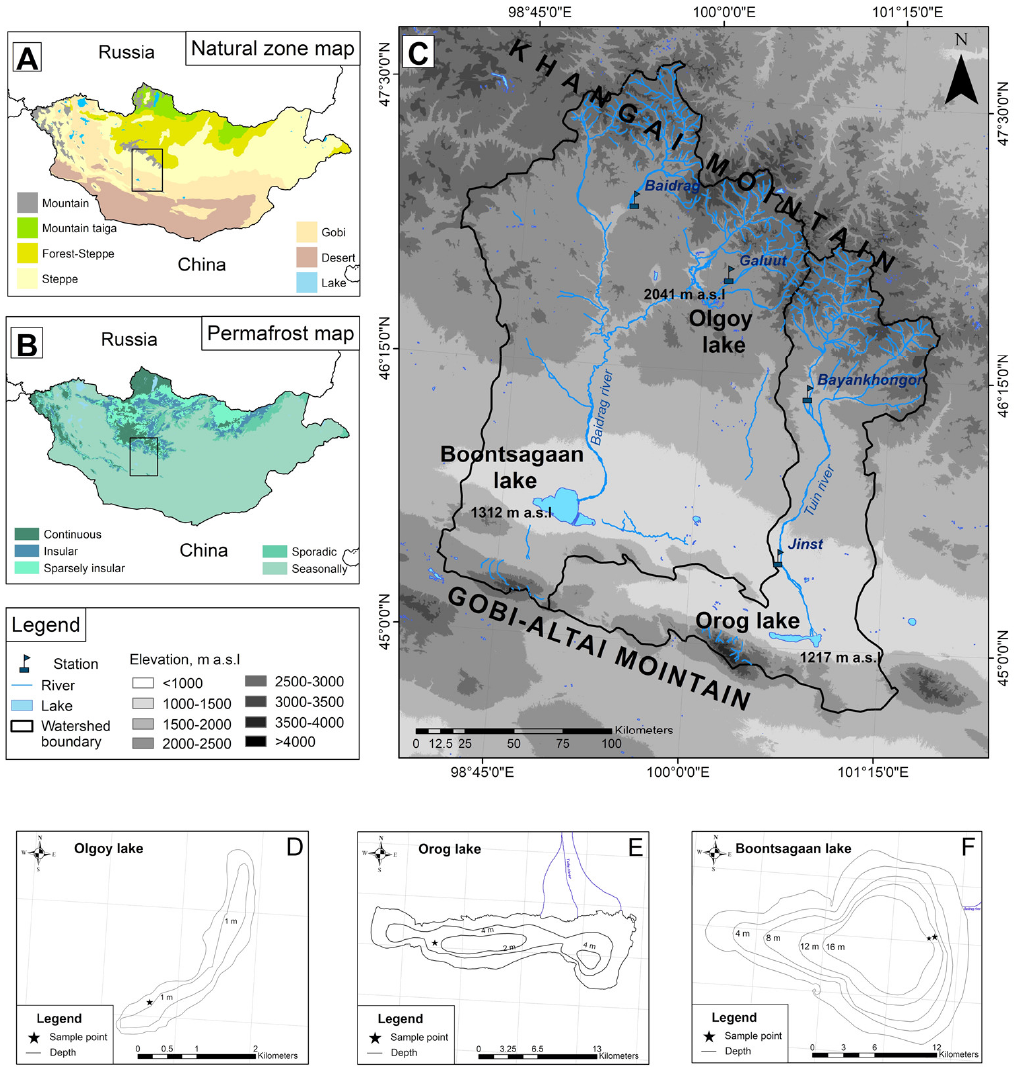
Figure 1. Location of the research area: ( A ) natural zone map; ( B ) permafrost map; ( C ) Boontsagaan and Orog watershed area; and ( D ) bathymetric maps of Olgoy Lake; ( E ) Orog Lake; and ( F ) Boontsagaan Lake (modified from [21]).